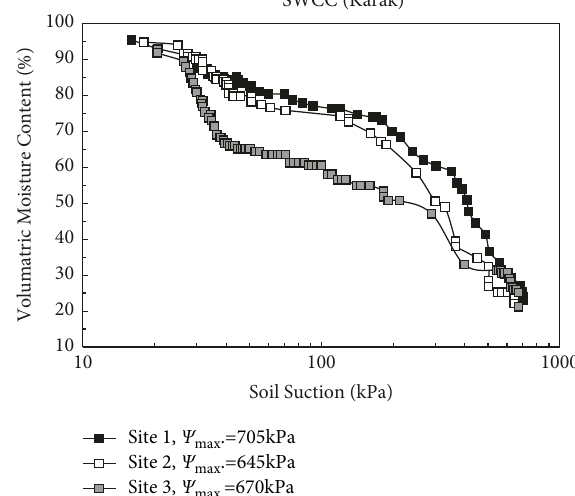
Figure 3: Demonstration of field-based SWCCs for sites S S 3 in Karak Expansive